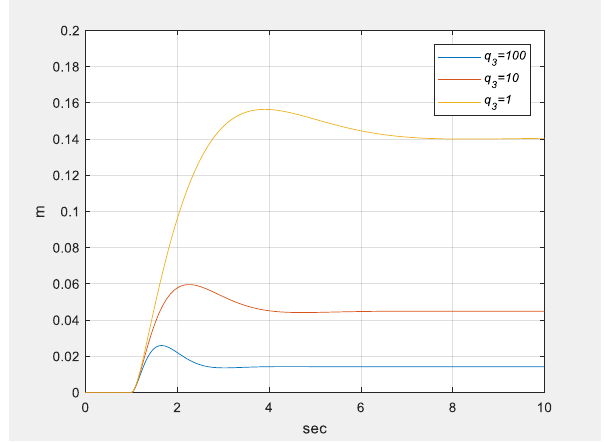
q on displacement 3